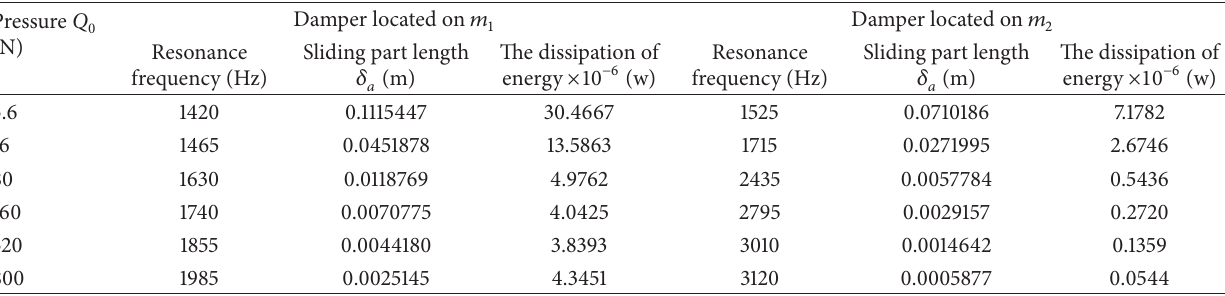
Table 3: Energy dissipation of the damper at resonance